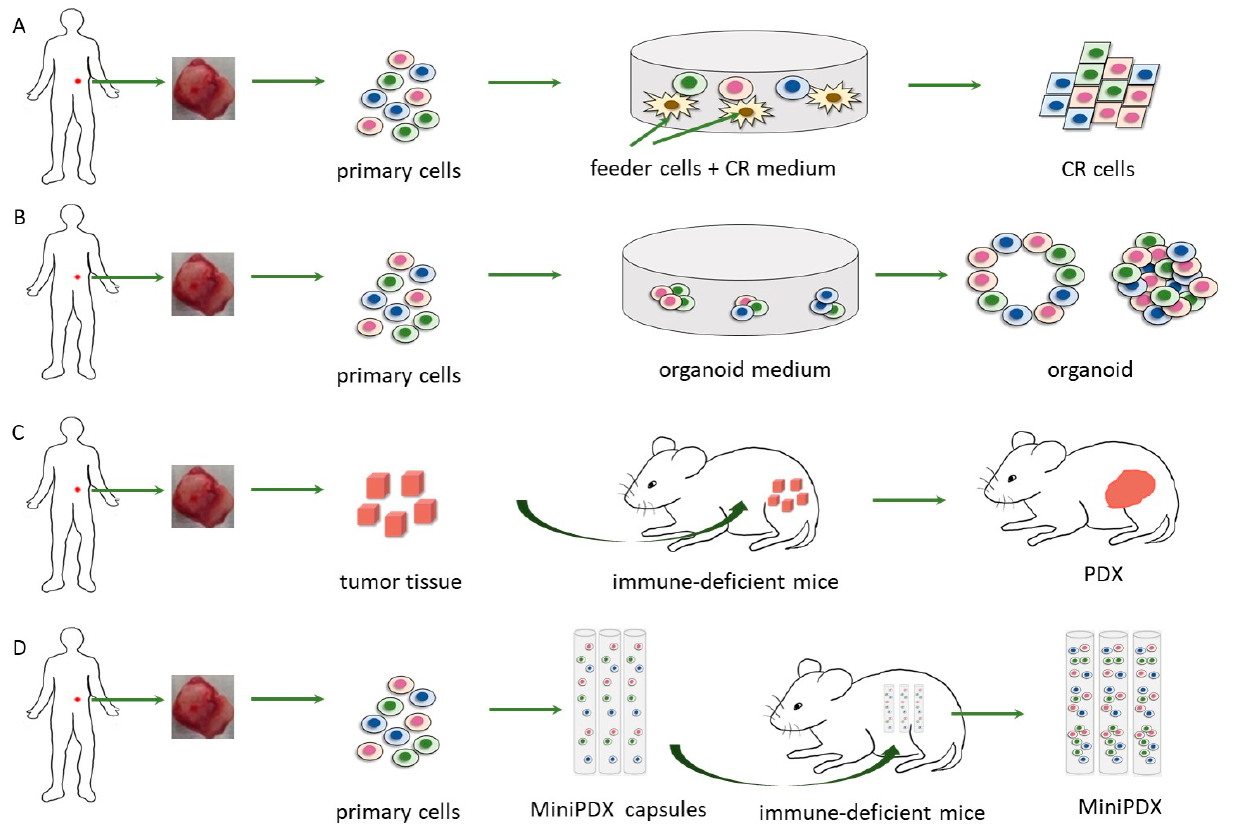
Figure 1. Schematic representation of CR cells, organoid, MiniPDX and PDX. For CR cells, organoids, and MiniPDX tumor tissues are diced and digested enzymatically to collect the primary suspension cells. ( A ). Tumor cells are co-cultured with feeder cells (irra- diated or mitomycin C-treated mouse fibroblasts) and CR medium added ROCK inhibitor Y-27632. ( B ). Patient-derived organoids are established by embedment into a 3D matrix and specific medium to grow into 3D organotypic structures. ( C ). PDX is established by subcutaneous or orthotopic implantation of surgical or biopsy tissue chunks into immune-deficient mice. ( D ). Primary cells are filled into OncoVee ® capsules and implanted subcutaneously via a small skin incision. The implanted capsules are removed after 7 days, and tumor cell proliferation is